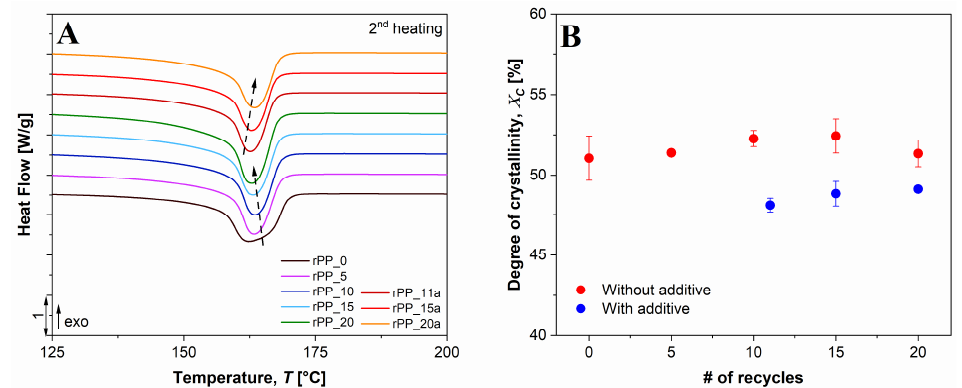
Figure 3. ( A ) DSC thermograms of melting peaks from the 2nd heating cycle of virgin PP, recycled PP without and with additive, and ( B ) the degree of crystallinity, determined by 2nd heating. Table 3. Thermal properties, obtained from the DSC of virgin PP, recycled PP with and without additive. 1st Heating Cooling 2nd